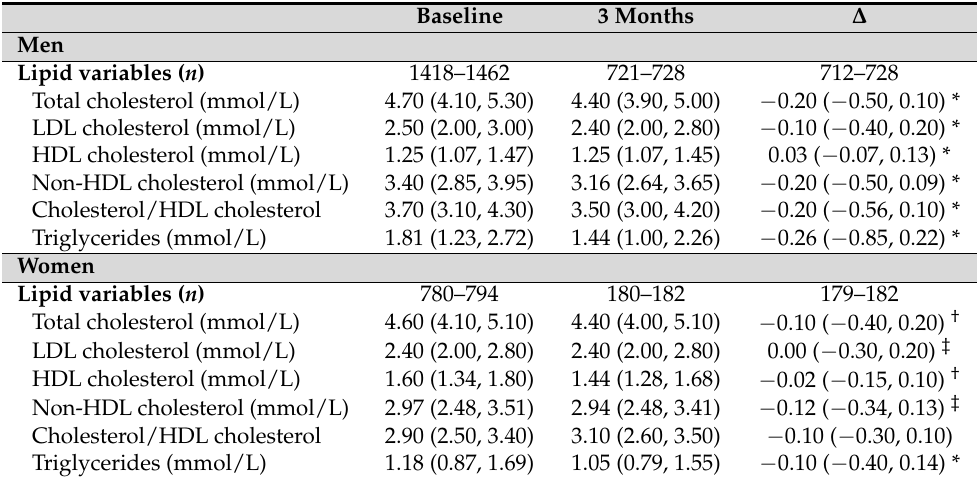
Table 3. Plasma lipid profile before and after the 3-month lifestyle modification program.